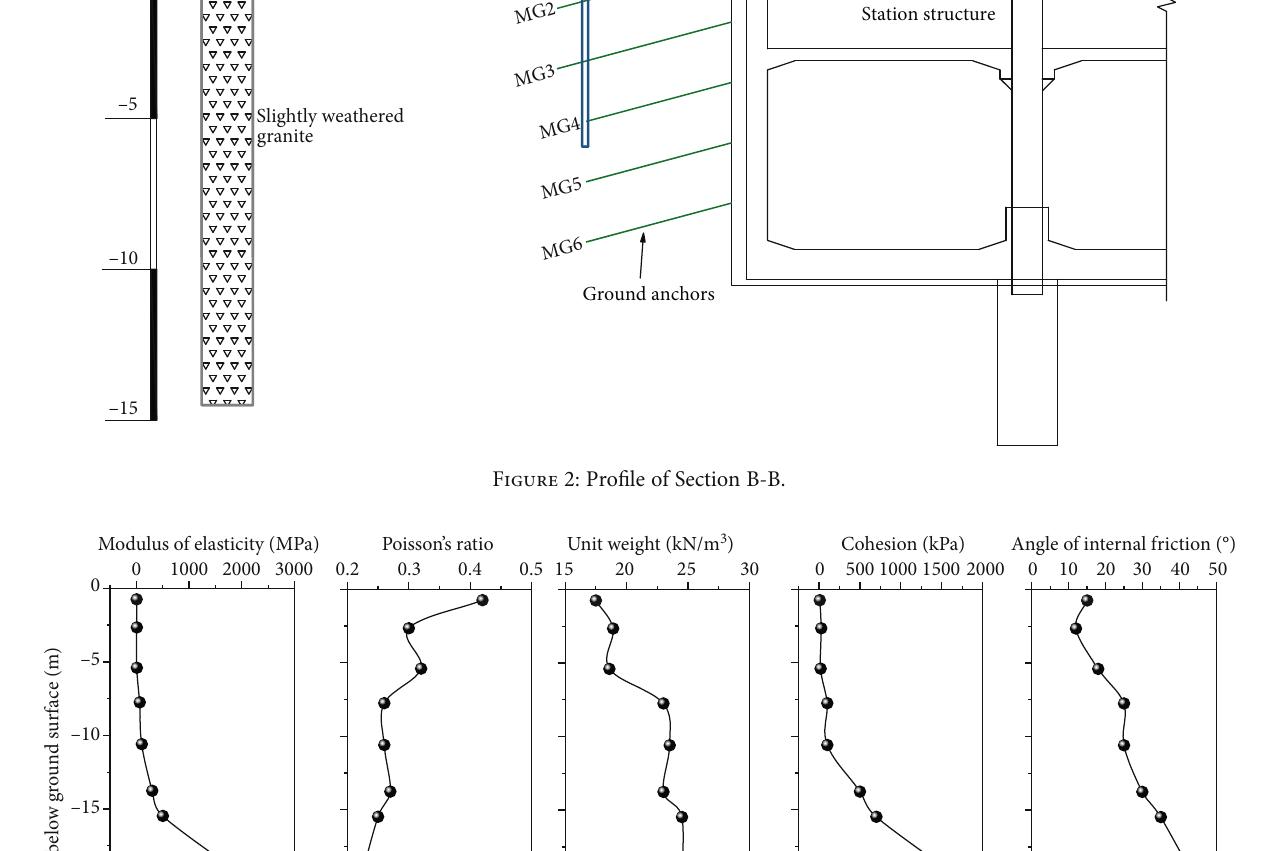
Figure 3: Variations of soil parameters with depth below ground